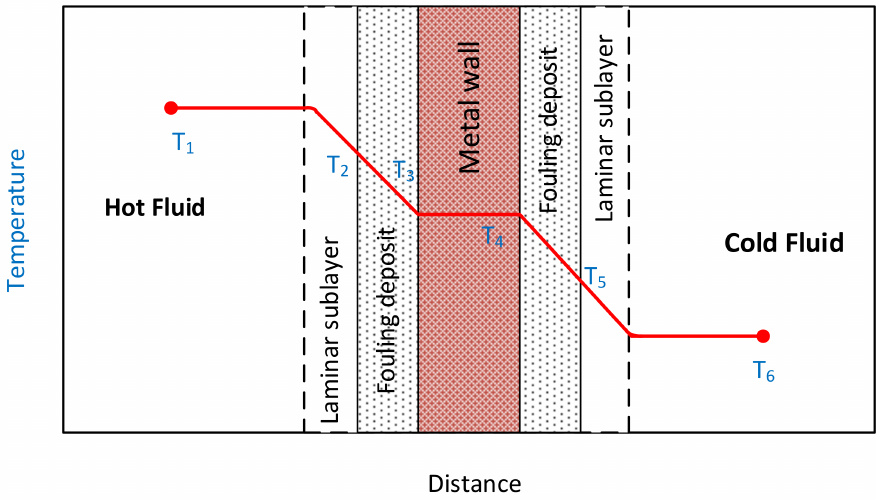
Figure 4. Temperature distribution of fouled heat exchanger (Adopted from